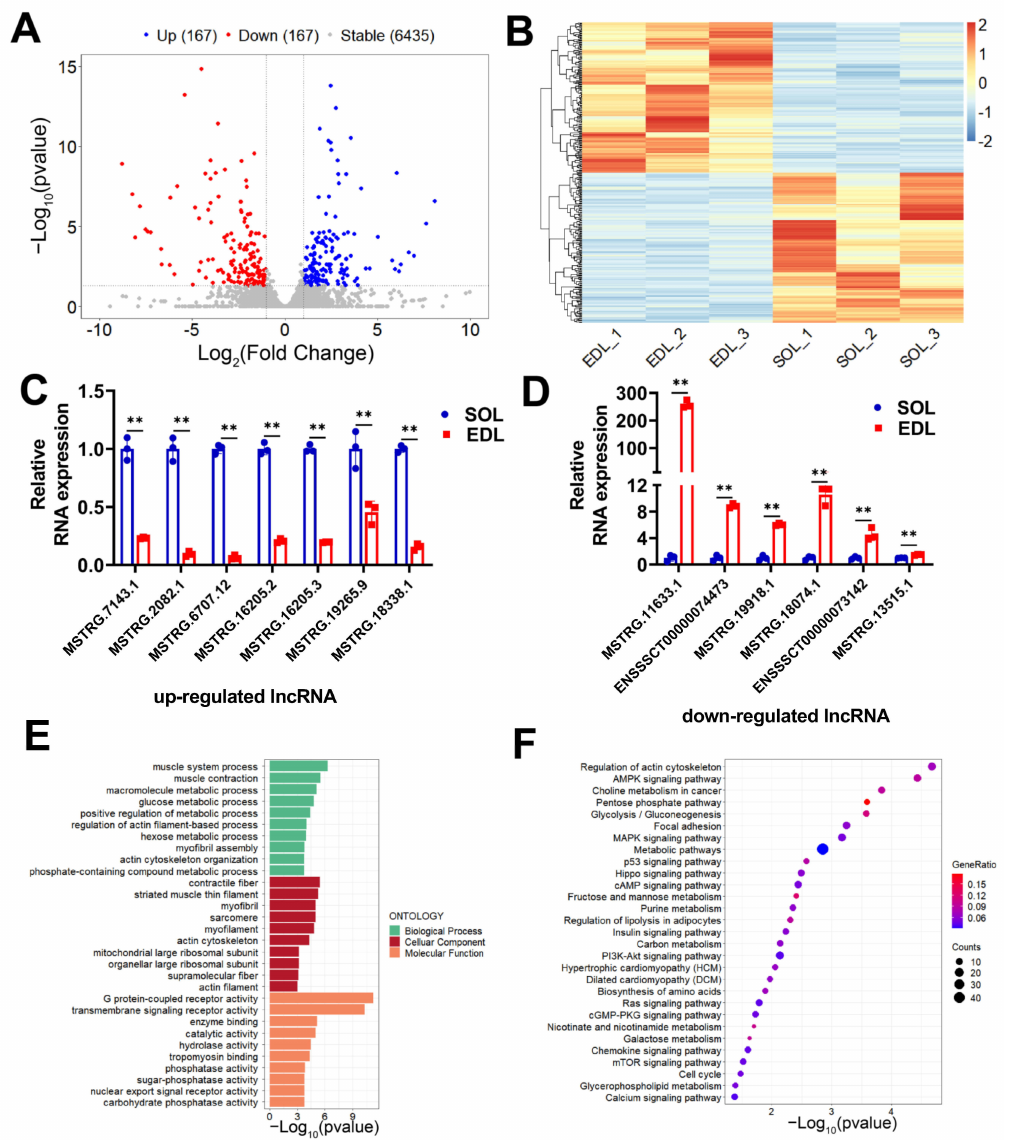
Figure 3. Screening and functional enrichment analysis of DE lncRNAs in SOL compared with EDL. ( A ) Volcano plot showing the expression profile of DE lncRNAs between SOL and EDL. Blue dots \\ SOL; grey dots represent lncRNAs with stable expression in both tissues. ( B ) Hierarchical clustering heatmap showing the expression profile of DE lncRNAs between SOL and EDL. ( C , D ) 7 upregulated ( C ) and 6 downregulated ( D ) DE lncRNAs were randomly selected and verified via qPCR. ( E ) GO enrichment analysis of the nearest target genes of DE lncRNAs. ( F ) KEGG pathway analysis of the nearest target genes of DE lncRNAs. The relative RNA expressions were standardized to that of the control gene β -actin. Data represent mean ± SD of three independent biological replicates. ** p <